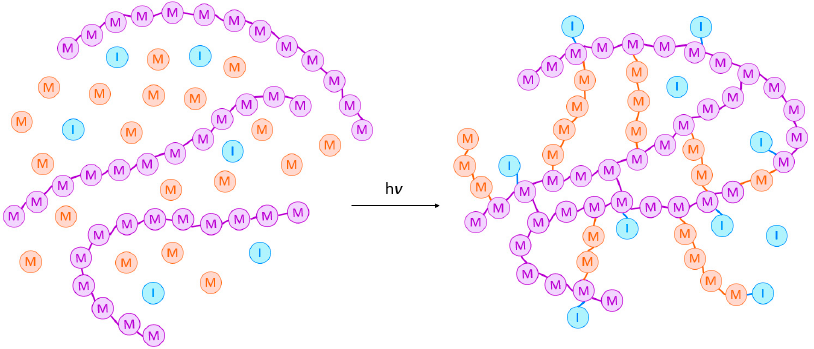
Figure 2. Schematic representation of the cross-linked polymer network obtained during a free radical polymerization reaction between oligomers (purple), monomers (orange) and photoinitiators (blue).